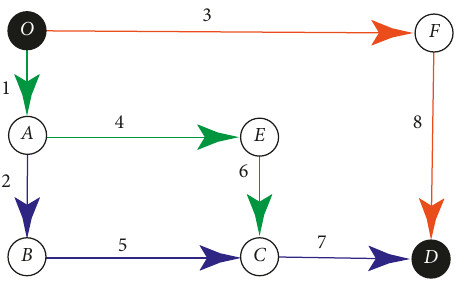
Figure 1: Path selection behavior